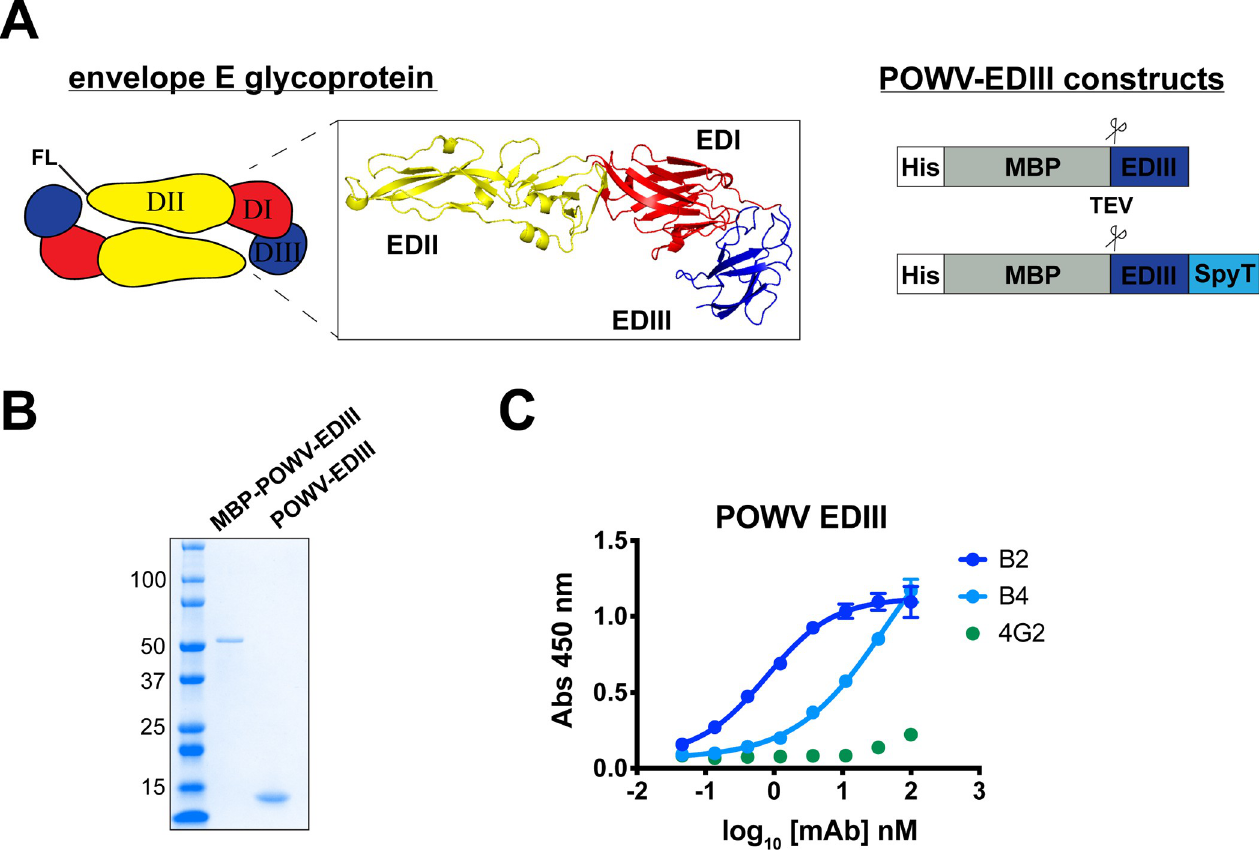
Fig 1. Design, expression, and purification of recombinant POWV EDIII. ( A ) Schematic of POWV E protein homodimer and POWV EDIII wild-type and Spy-tagged (SpyT) expression constructs. FL refers to fusion loop peptide contained in EDII. Inset shows structure of TBEV E glycoprotein (PDB: 1SVB). Expression constructs contain the POWV EDIII sequence as C-terminal fusion to His-tagged MBP and include a TEV protease cleavage site as indicated. ( B ) Coomassie stained SDS-PAGE gel of MBP-POWV-EDIII fusion protein and cleaved wild-type POWV EDIII. ( C ) ELISA reactivity of mAbs B2 and B4 toward POWV EDIII. MAb 4G2 is a negative control. ELISAs were performed twice independently in triplicate wells (mean ±